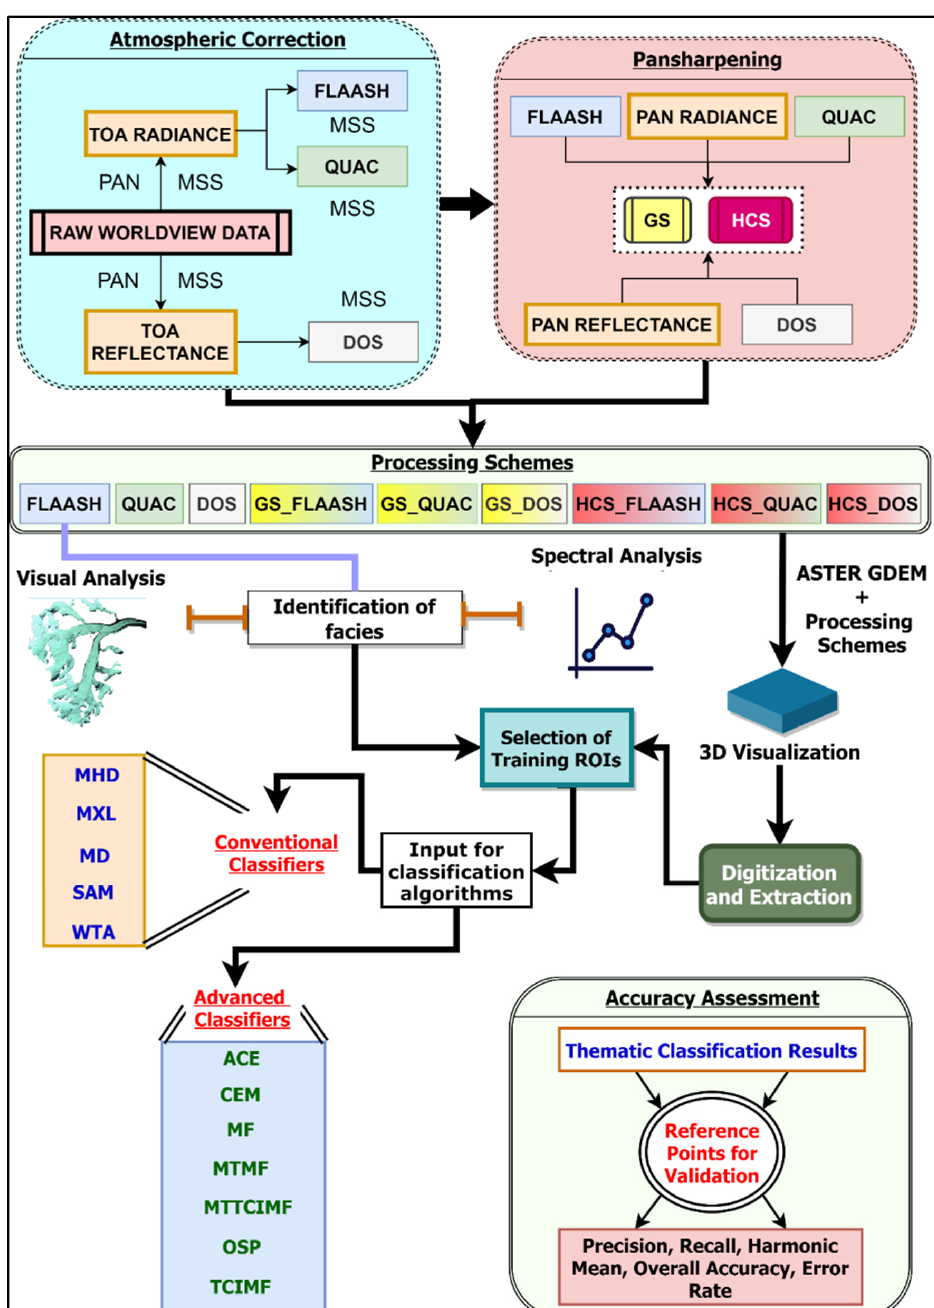
Figure 2. Experimental set up of the study. TOA: Top of Atmosphere; PAN: Panchromatic; MSS: Multispectral; DOS: Dark Object Subtraction; FLAASH: Fast-Line-of-Sight Atmospheric Analysis of Spectral Hypercubes; QUAC: Quick Atmospheric Correction; GS: Gram–Schmidt; HCS: Hyperspherical Color Space; MHD: Mahalanobis Distance; MXL: Maximum Likelihood; MD: Minimum Distance; SAM: Spectral Angle Mapper; WTA: Winner Takes All; ACE: Adaptive Coherence Estimator; CEM: Constrained Energy Minimization; MF: Matched Filtering; MTMF: Mixture-Tuned Matched Filtering; MTTCIMF: Mixture-Tuned Target-Constrained Interference-Minimized Filter; OSP: Orthogonal Space Projection; TCIMF: Target-Constrained Interference-Minimized Filter.